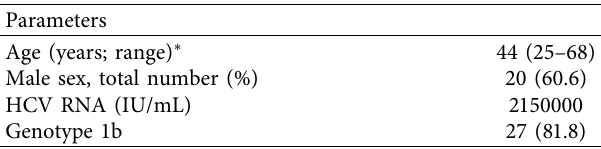
Table 1: Demographic and clinical characteristics of patients with chronic hepatitis C.